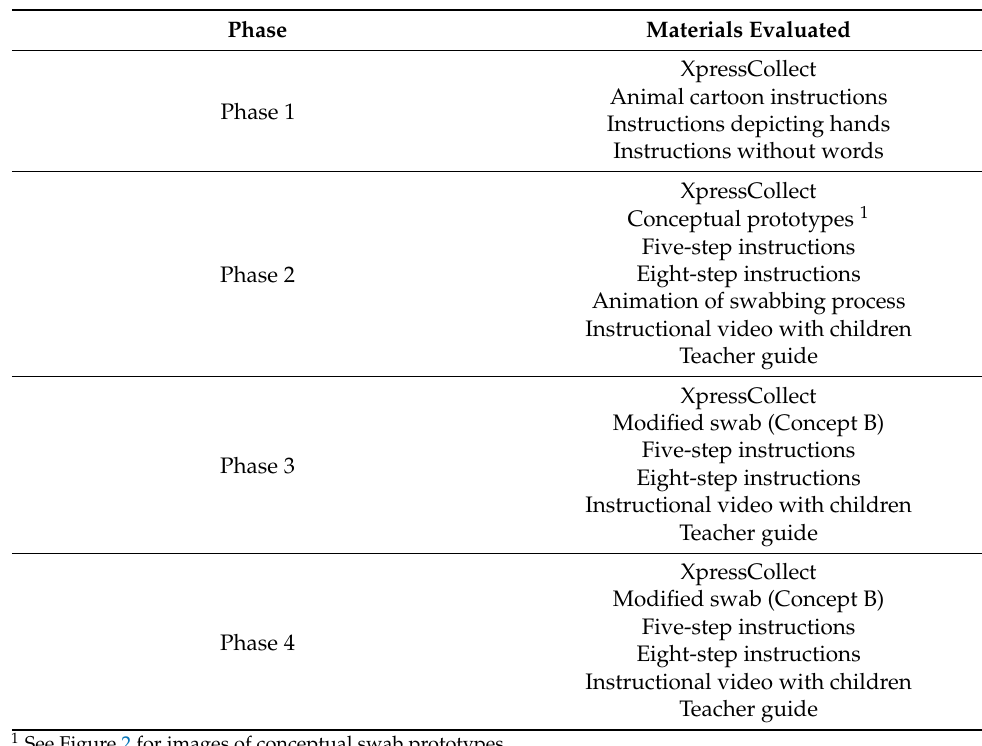
Table 3. Materials evaluated during the associated study phases.